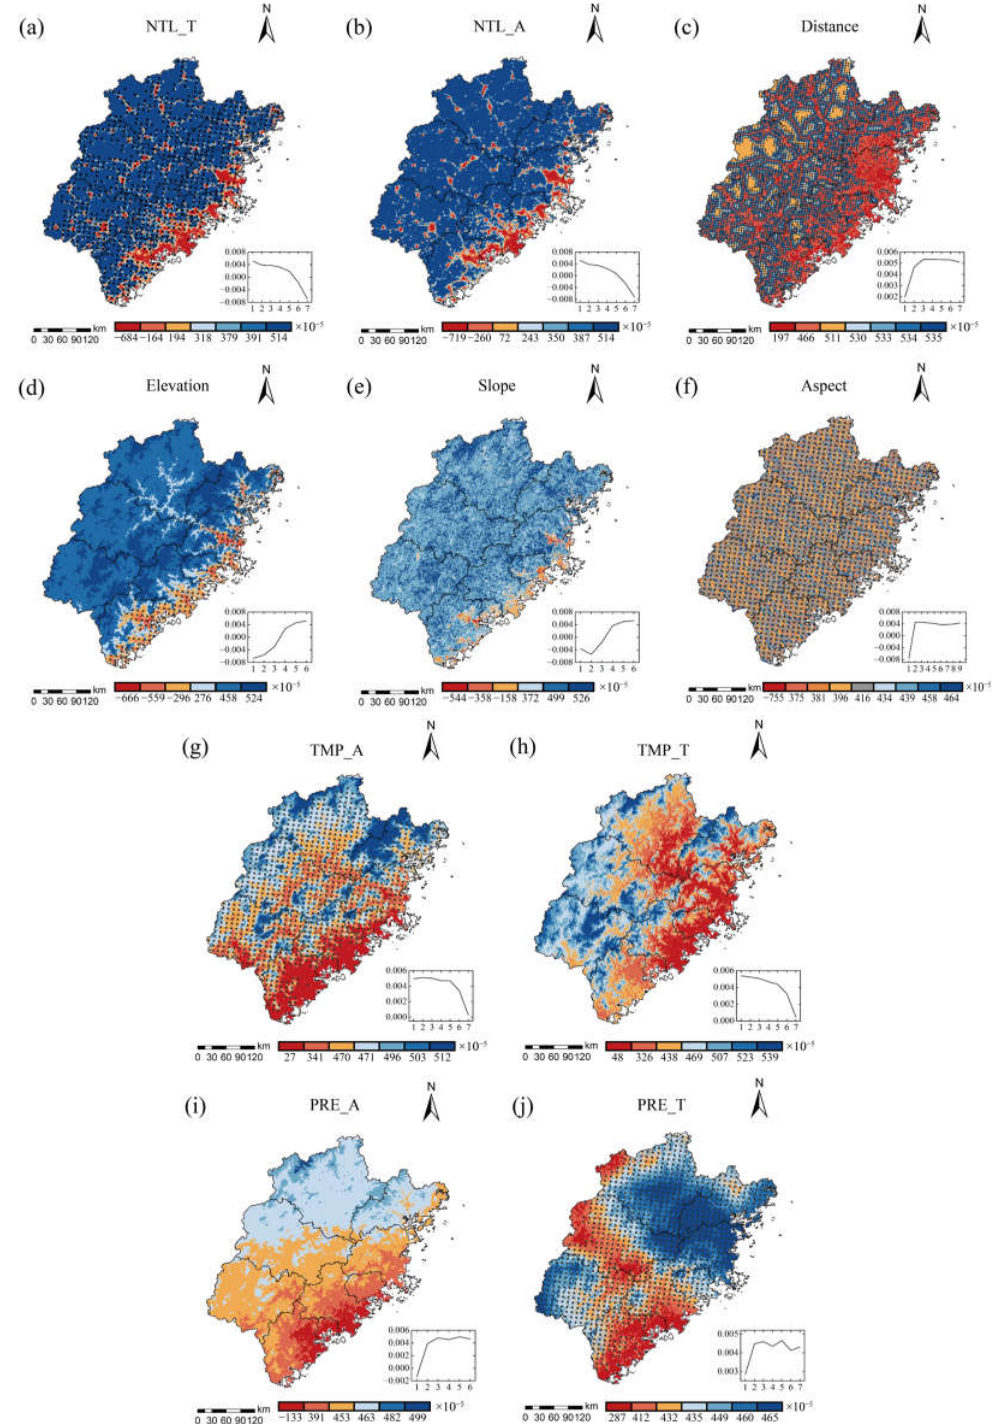
Figure 7. The gradient of mean s of 10 variables. The regions marked with dots are not statistically significant. The mean s with the change of the variable was draw in the bottom-right for each panel. ( a ) The spatial pattern of the mean s of NTL_T. The numbers from 1 to 7 denote 7 intervals in NTL_T, respectively: −1.96~0, 0~0.0006, 0.0006~0.018, 0.018~0.06, 0.06~0.14, 0.14~0.36, 0.36~6.67; ( b ) The spatial pattern of the mean s of NTL_A. The numbers from 1 to 7 denote 7 intervals in NTL_A, respectively: 0~0.004 nW cm −2 sr −1 , 0.004~0.06 nW cm −2 sr −1 , 0.06~0.2 nW cm −2 sr −1 , 0.2~0.5 nW cm −2 sr −1 , 0.5~1.1 nW cm −2 sr −1 , 1.1~3.4 nW cm −2 sr −1 , 3.4~56.9 nW cm −2 sr −1 ; ( c ) The spatial pattern of the mean s of Distance. The numbers from 1 to 7 denote 7 intervals in Distance, respectively: 0~235.9 m, 235.9~1685.4 m, 1685.4~3135 m, 3135~4584.5 m, 4584.5~6034 m, 6034~7483.6 m, 7483.6~25000 m; ( d )